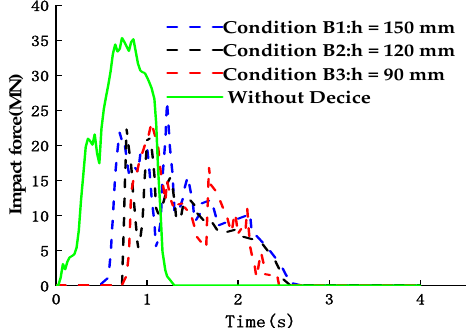
Figure 23. Impact force time-history curve of the pier.